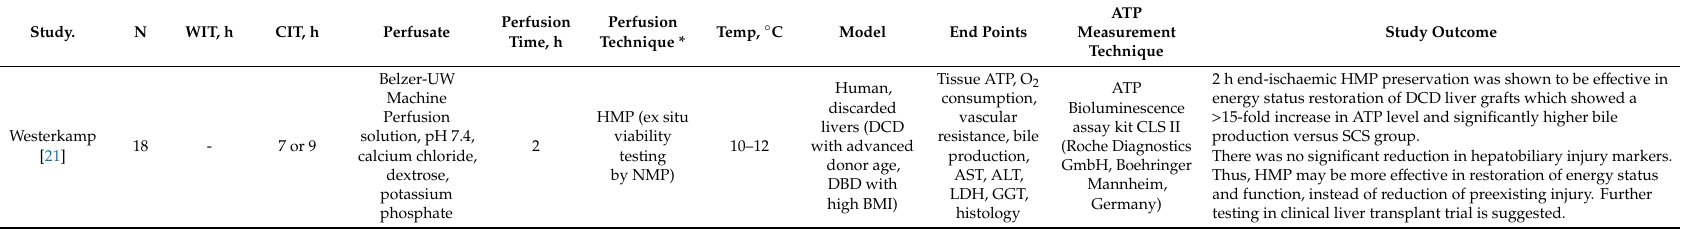
Table 1. Characteristics and outcomes of key pre-clinical and animal study investigating HMP preservation of livers.